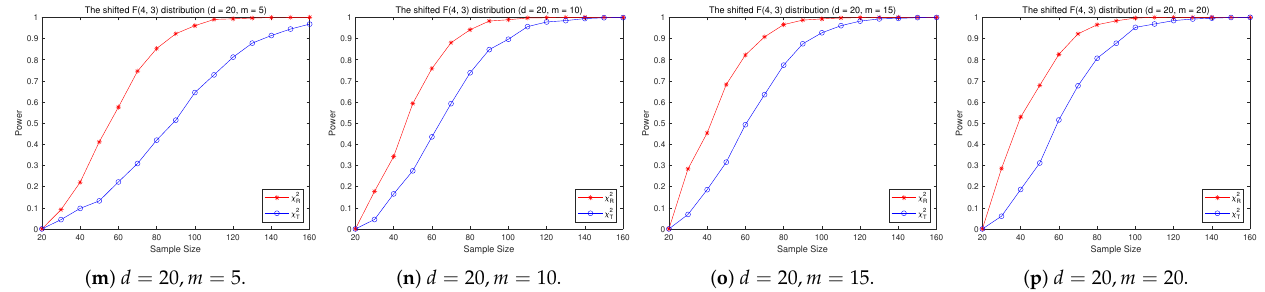
Figure 6. The shifted F distribution F ( 4,3 ) . Red line for RP-chi-square, blue line for traditional chi-square.